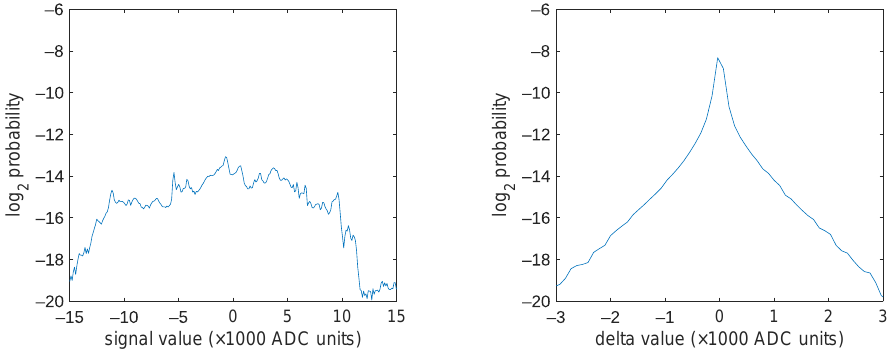
Figure 3. Probability distributions of the (centered) original signals and of their first differences. The entropies associated to these distributions are about 15bits for the original, and 10bits for the differential (delta), corresponding to maximum per-sample compression ratios of 61% and 42% respectively. A good compressor should be able to leverage correlation between samples and thus, unless the input is a white noise, should achieve lower rates than the (single) sample entropy.